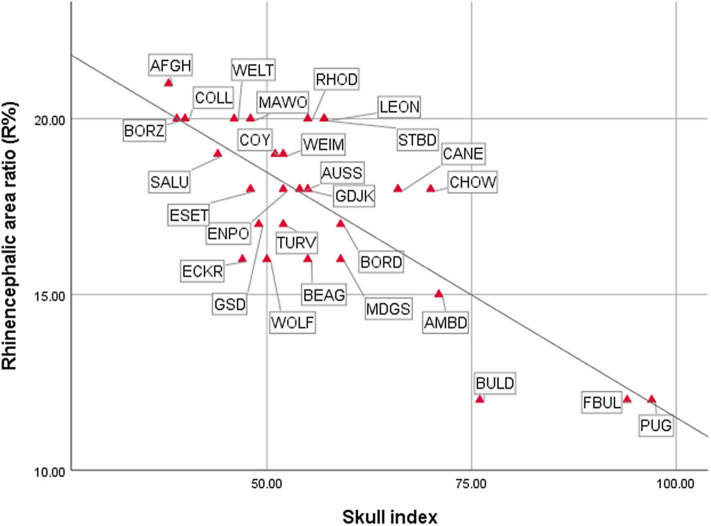
Correlations between cranial and endocranial measurements. For breed/species name abbreviations, see Figure 10.